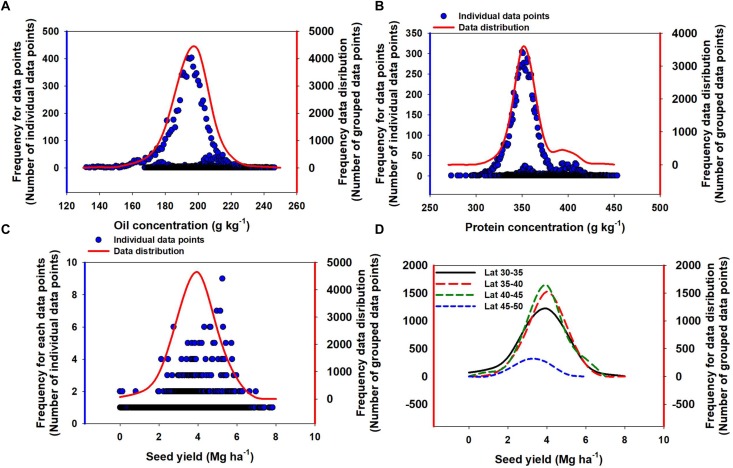
Frequency distribution for individual data points and an overall distribution for soybean oil concentration (A), protein concentration (B), seed yield (C), and seed yield by latitude (D). Line data distributions were calculated by grouping values to the nearest whole number and adding the frequency of each of the grouped values to arrive at the frequency for the group.